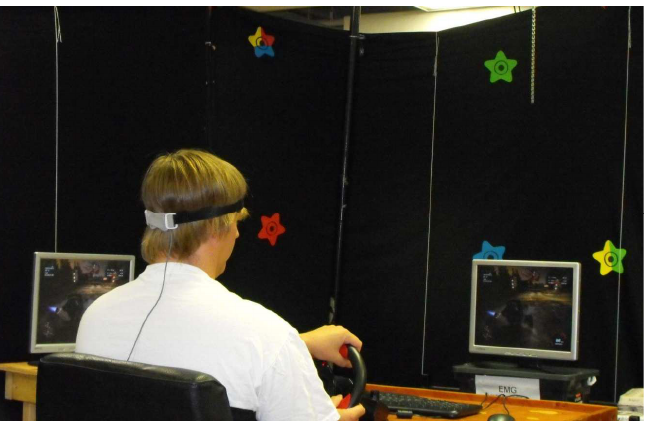
Figure 4. Example of the typical placement of the adjustable headband secured to the back of the participant’s head just below occipital protuberance.